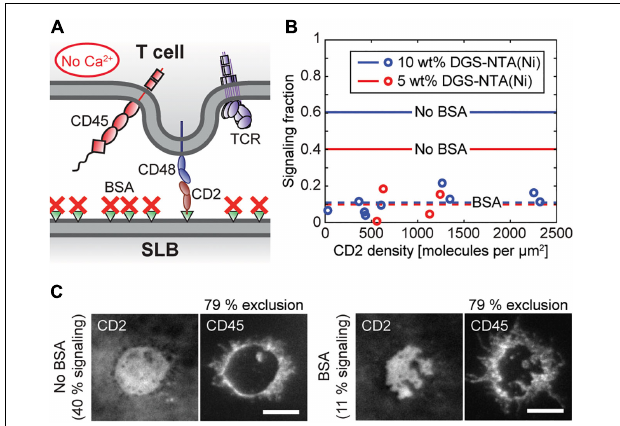
FIGURE 3 | Calcium signaling is significantly reduced upon blocking the SLB with BSA, without affecting CD45 exclusion. (A) Schematic illustration of the BSA-blocked and CD2-functionalized SLB in contact with a T cell. (B) The signaling fraction of cells on BSA-blocked SLBs containing either 5 wt% DGS-NTA(Ni) (red circles) or 10 wt% DGS-NTA(Ni) (blue circles) at different CD2 densities. Each data point represents one experiment with 150 analyzed cells. The solid lines represent the average values on a non-blocked SLB [5 wt% DGS-NTA(Ni): blue line, 10 wt% DGS-NTA(Ni): red line], whereas the dashed lines correspond to the average signaling fraction for the BSA-blocked SLBs. (C) Fluorescence images of two representative cell-SLB contacts in the CD2 and the CD45 channel without ( left ) and with ( right ) BSA blocking. The SLBs contained 5 wt% DGS-NTA(Ni) and had ∼ 1,000 CD2 molecules per µ m 2 . The scale bars are 5 µ